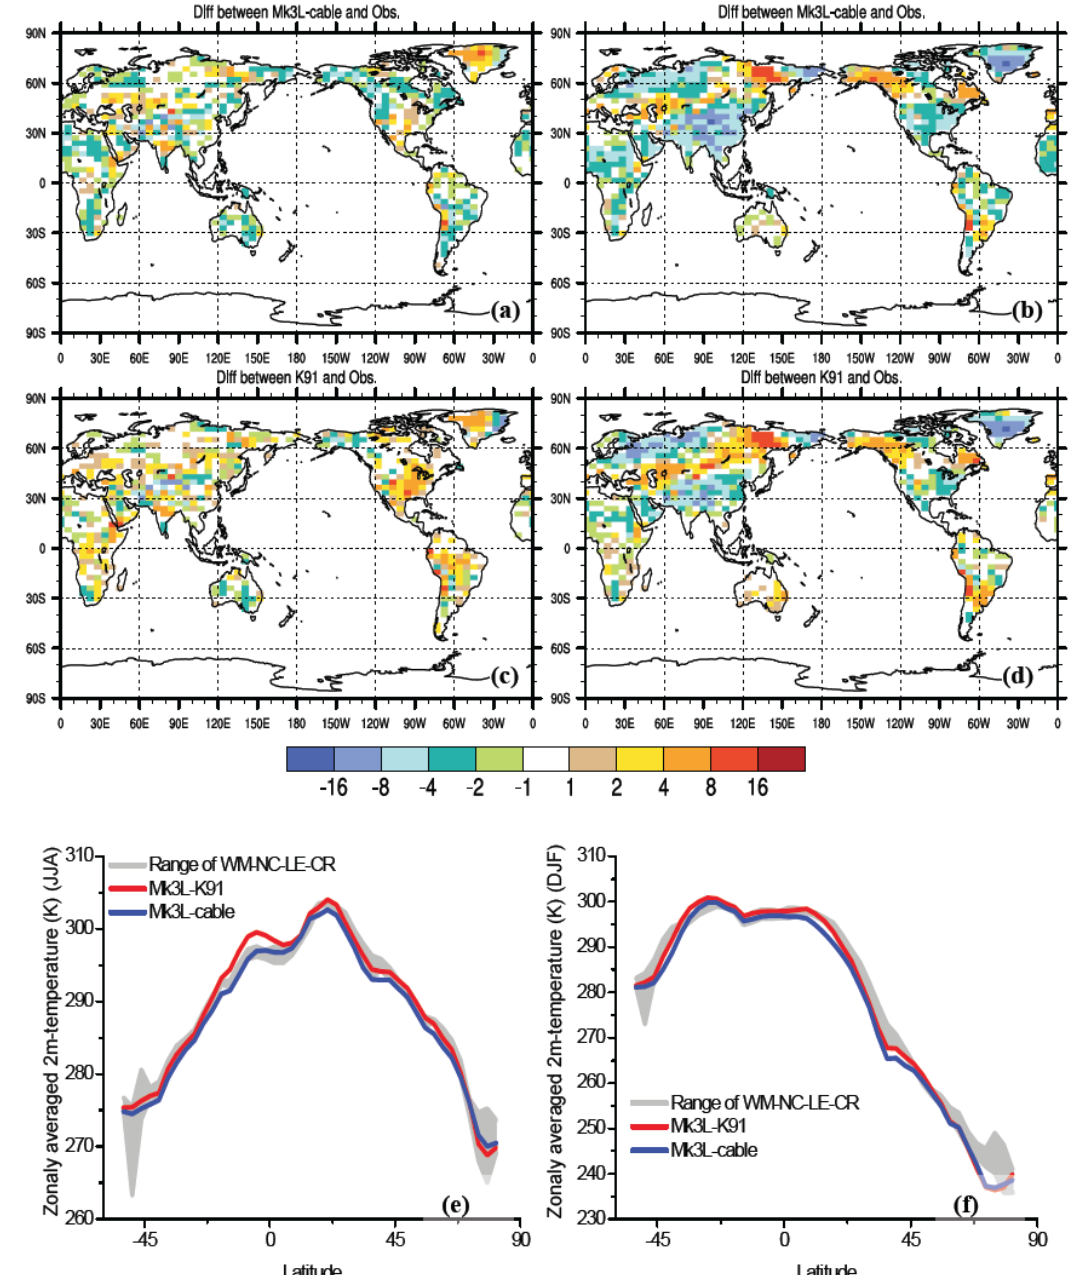
Fig. 3. The 2m air temperature differences (K) relative to observations for (a) Mk3L-CABLE for JJA; (b) Mk3L-CABLE for DJF, (c) Mk3L- K91 for JJA and (d) Mk3L-K91 for DJF. In each case the model is differenced from the CRU (New et al., 2000) climatology. In the lower panels the observed range is shown for WM (Willmott and Matsuura, 2001), NC (Kalnay et al., 1996), LE (Legates and Willmott, 1990) and CR (New et al., 2000). Only values over continental surfaces are